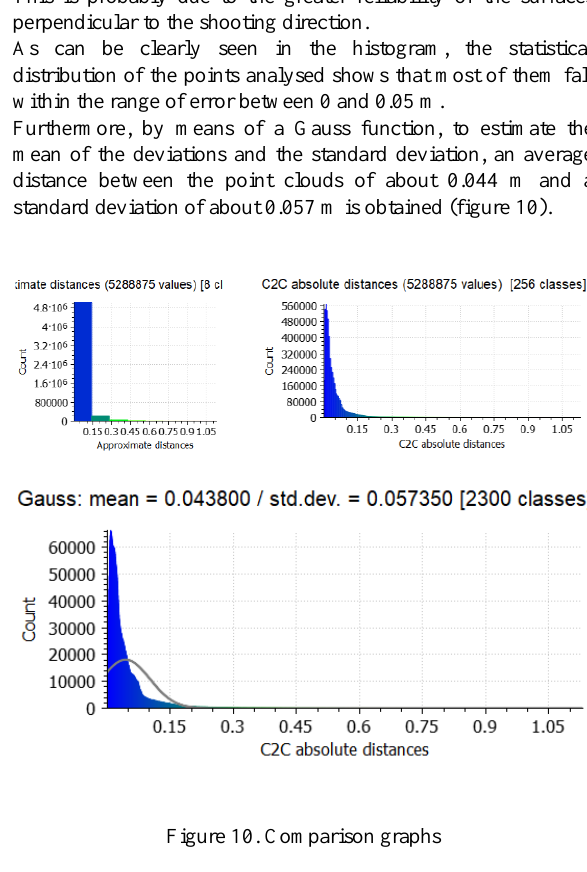
Figure 10. Comparison graphs